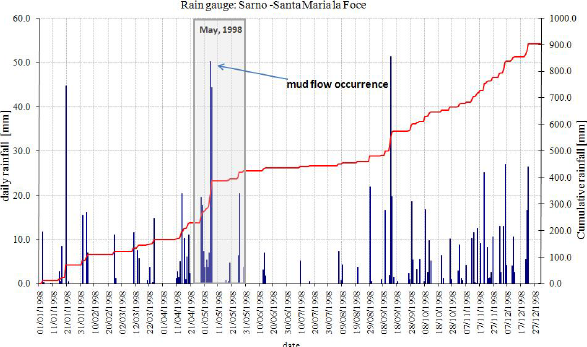
Figure 4. Comparison of daily and cumulative rainfall data recorded at Sarno rain gauge in